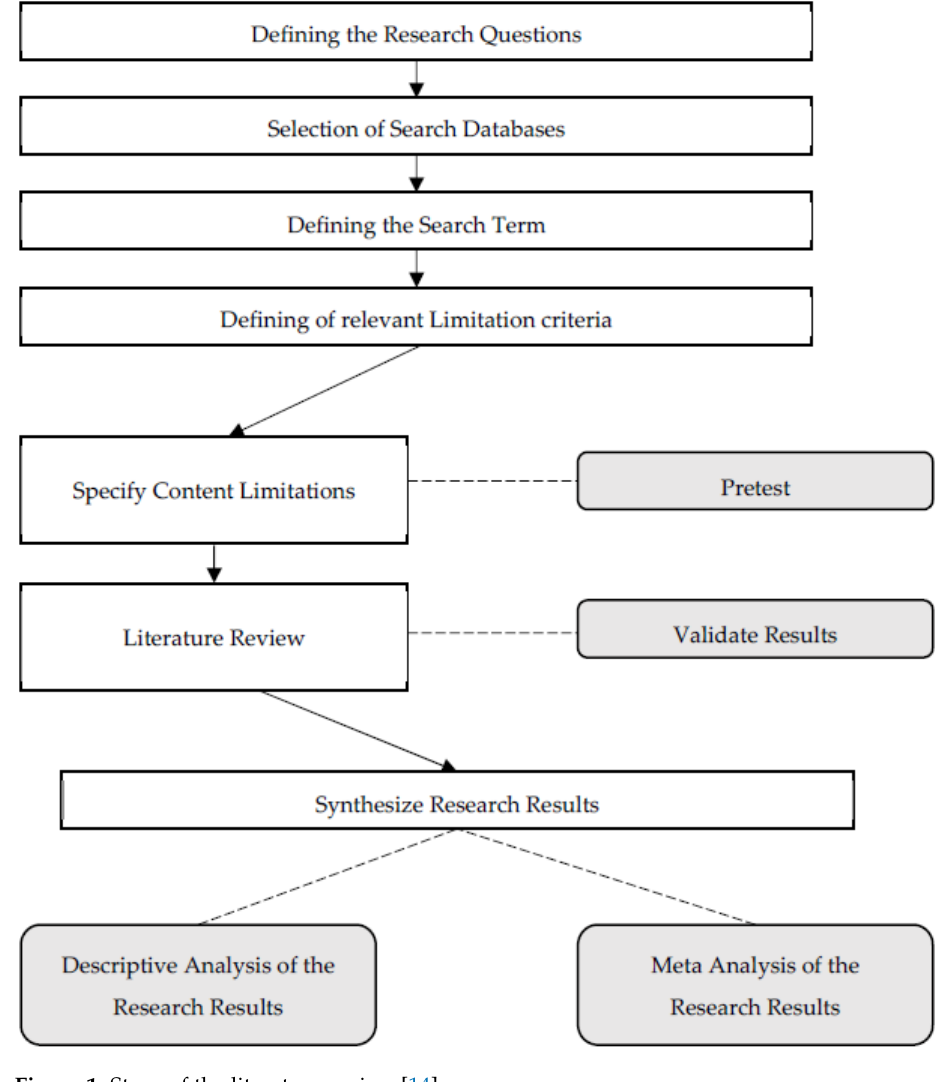
Figure 1. Steps of the literature review [14].